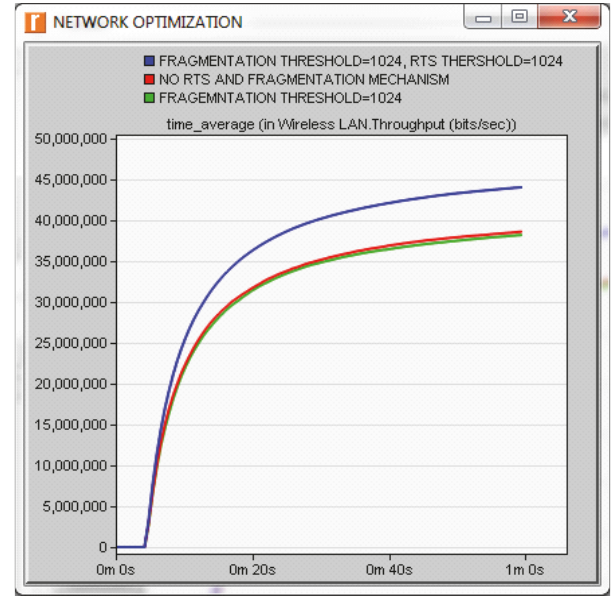
Figure 21: WLAN throughput optimization with RTS and fragmen- tation